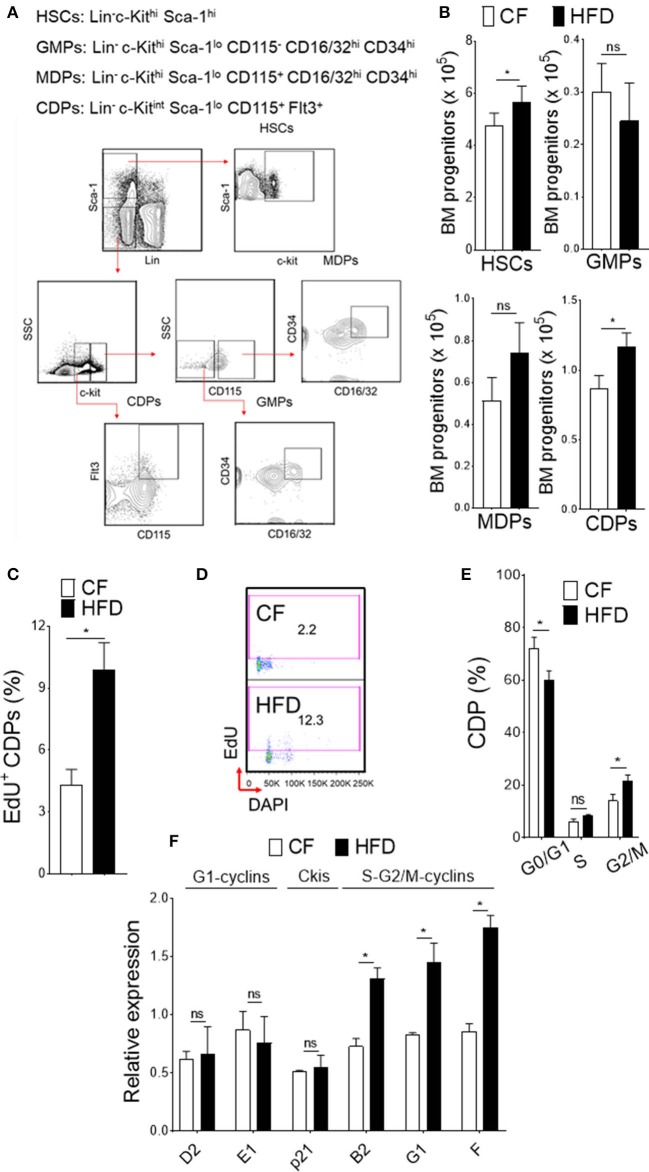
DC restricted precursor maintain a highly proliferative state in obesity. (A) Phenotypic definition and gating strategy of BM progenitors. (B) Enumeration of progenitors in diet-induced obese mice (HFD) compared with chow fed (CF) control mice. n = 10/group. (C) Mean percentages of EdU (5-ethynyl-2′-deoxyuridine) showing proliferation of BM CDPs from EdU-treated CF and HFD mice. n = 5/group. Two independent experiments. Results are expressed as mean ± s.e.m. (D) Representative FACS plot and (E) mean percentages of cell-cycle profile showing CDPs from CF and HFD mice. n = 5 mice/group. (F) qRT-PCR analyses for G1-cyclins (D2, E1), Ckis (p21), and S-G2/M-cyclins (B2, G1, and F) gene expression in BM CDPs isolated from CF and HFD mice. Two independent experiments. Results are expressed as fold change ± s.e.m normalized to β-actin expression. n = 4/group. Student's t-test *P < 0.05.